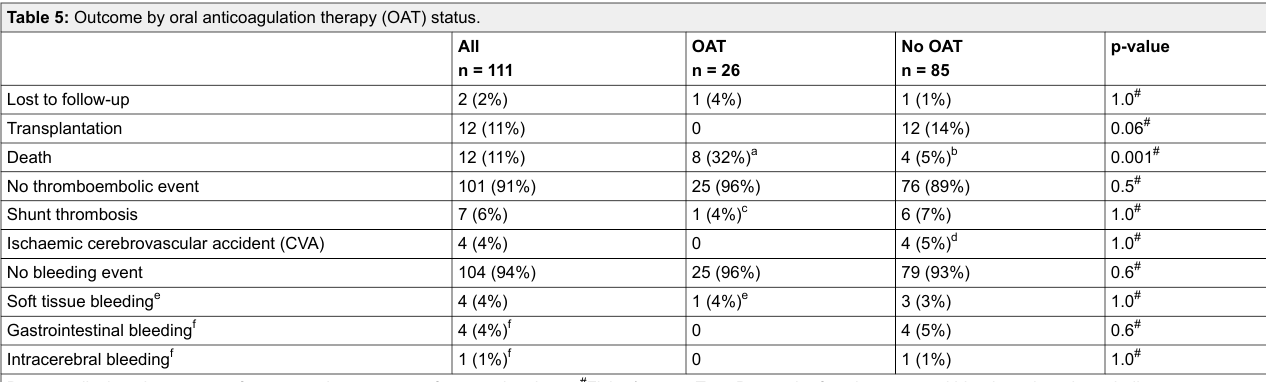
Table 5: Outcome by oral anticoagulation therapy (OAT) status.